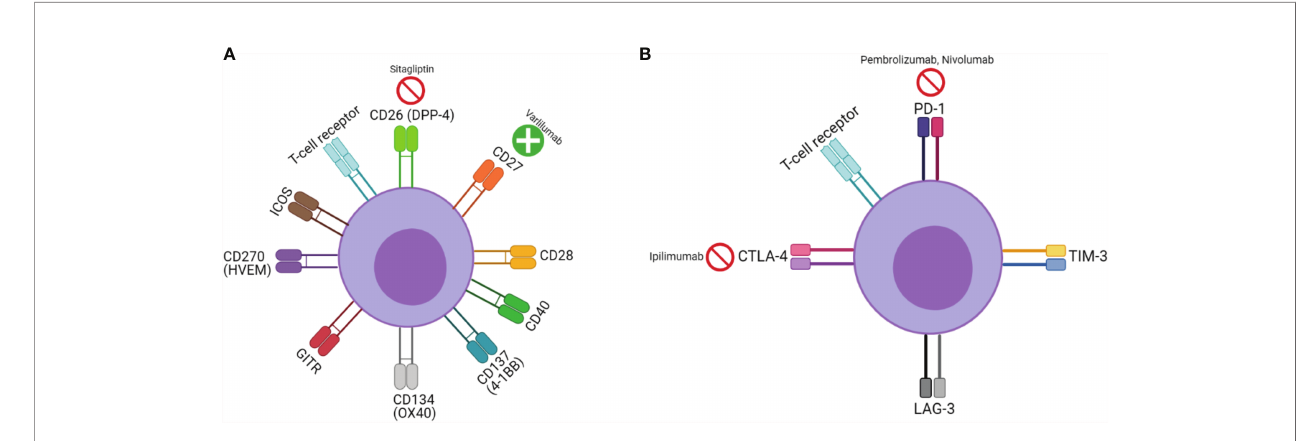
FIGURE 1 | T-cell signaling, function, and pharmacologic targets: (A) Co-stimulatory receptors and (B) inhibitory receptors; represents inhibitor, represents